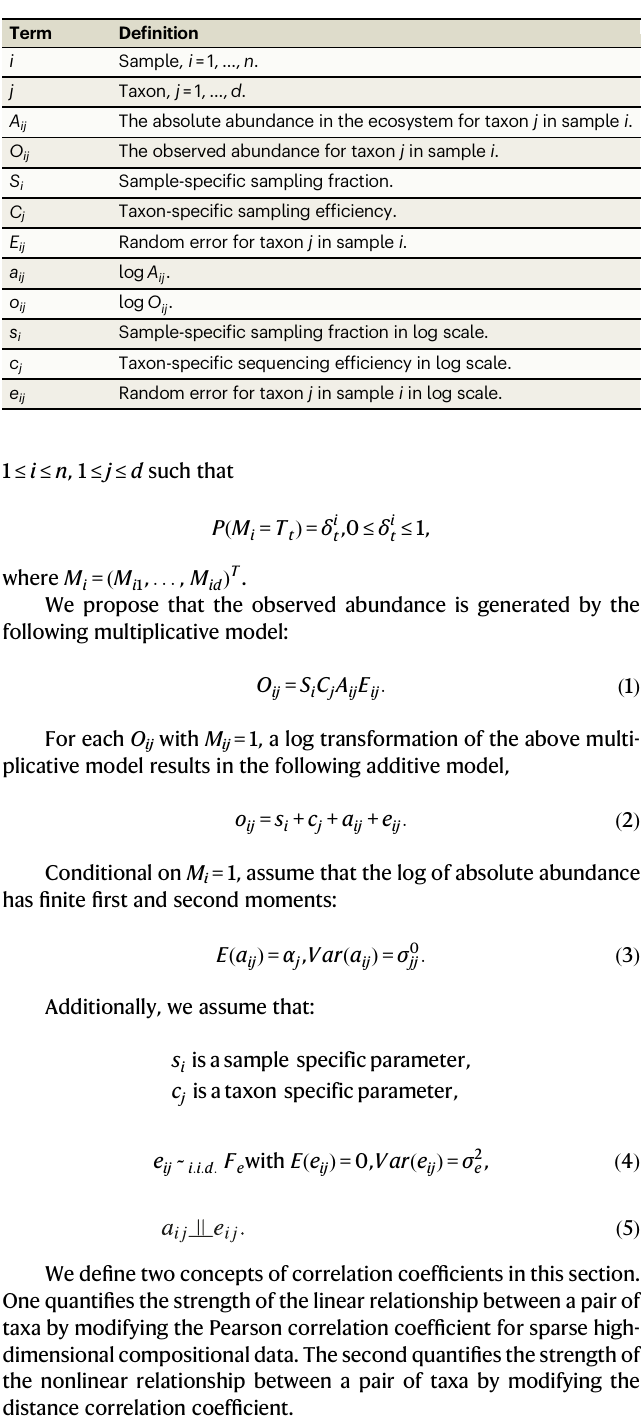
Table 1 | De fi nitions of key